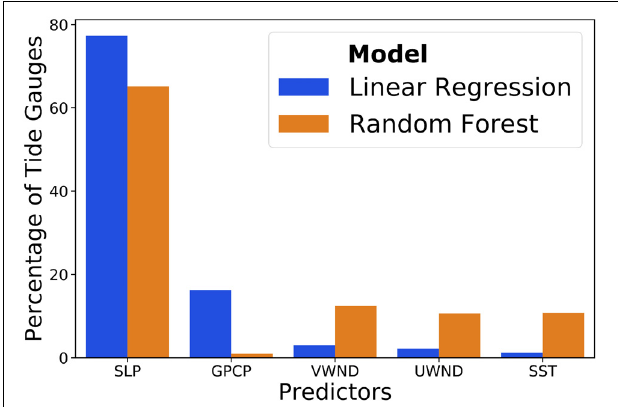
FIGURE 9 | Percentage of the number of tide gages where individual predictors are deemed most relevant (see text for more details) for Model-RS for stepwise regression and Random Forest; VWND and UWND are zonal and meridional wind